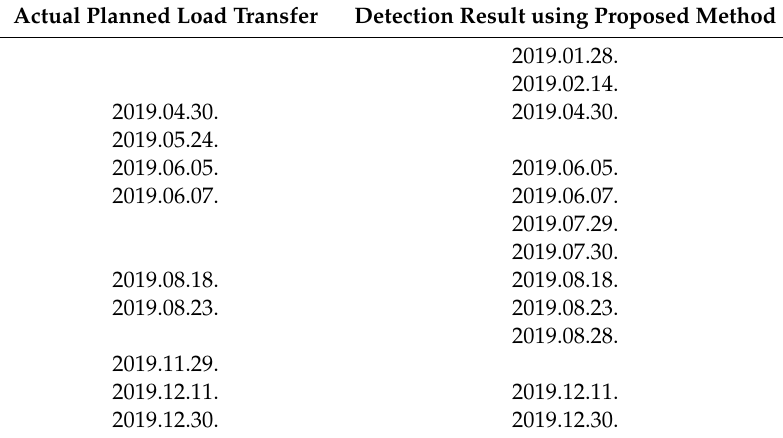
Table 1. Comparative result of load transfer (Kimhwa D / L)